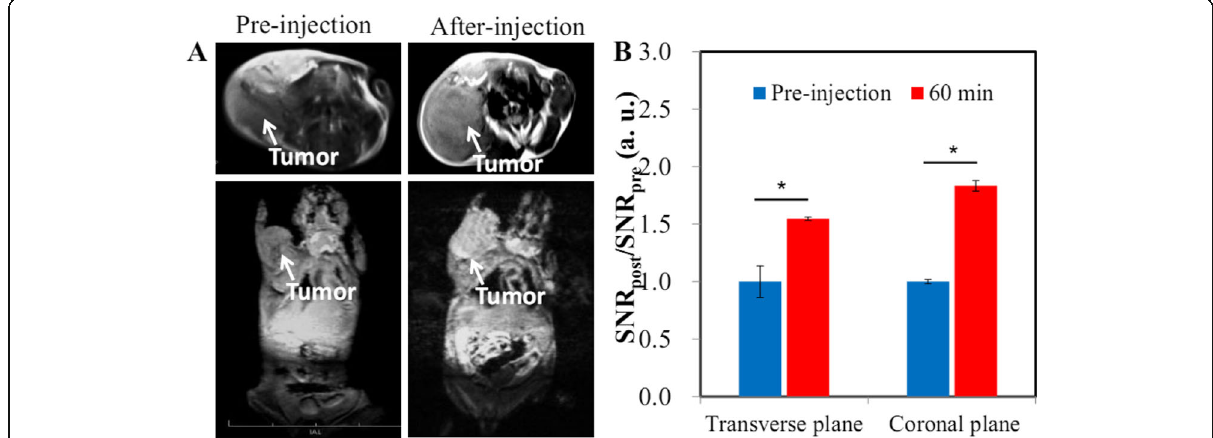
Fig. 5 T 1 -weighted MR imaging ( a ) and corresponding quantificational analysis ( b ) of Heps mouse liver cancer xenograft tumors after intravenous injection of HA-Gd 2 O 3